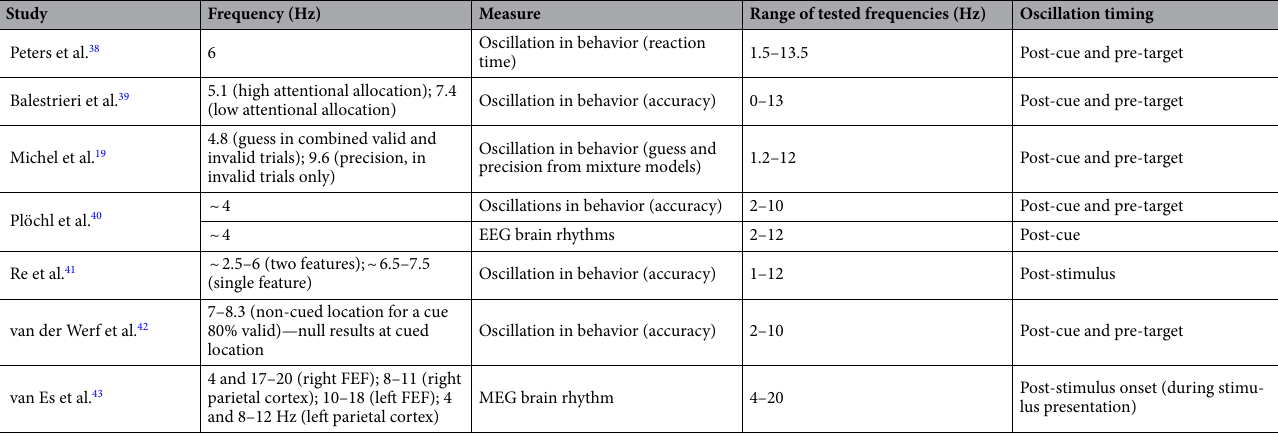
Table 1. Studies demonstrating periodic phase effects during covert visual attention tasks in human and non-human primates. These studies were the “Attention and search” studies in VanRullen 96 and updated based on a literature search (until January 2022). The same criteria were used to select the studies, i.e., studies explicitly manipulating covert visual attention and showing a link between instantaneous phase and behavioral performance (from these studies, we only report results regarding oscillations in behavior, as well as analyses linking instantaneous neural phase and behavioral performance). Studies “entraining” brain oscillations were not included (see VanRullen 96 , for more details). Properties of the periodicity are organized by species (non-human primate or human) and nature of the attentional manipulation (visual search or cueing; no other manipulation was found). Within these fields, the following sub-fields are included, from left to right: Study (chronological order); Frequency of significant rhythm (some of these values were not clearly reported in the publication and thus correspond to estimations based on Figure reading; indicated with ~); Measure used in the study to reveal periodicity; Range of all tested frequencies; Oscillation timing relative to trial events. Note that the table does not include negative findings. LFP: Local Field Potential. FEF: Frontal Eye Field.